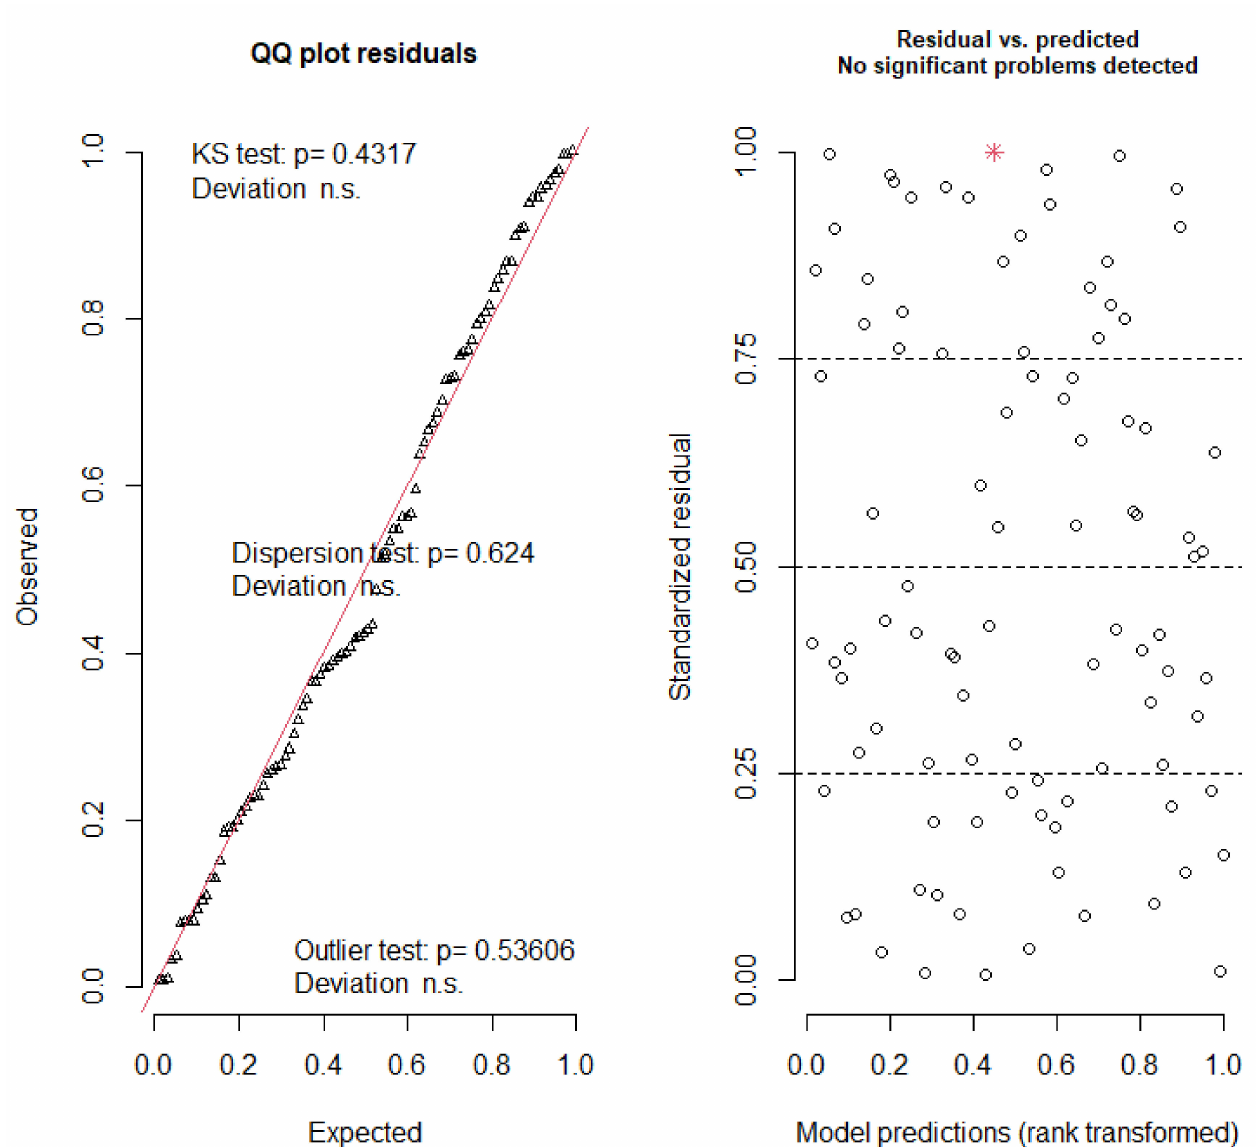
Figure A3. Q-Q plot and the residuals versus the predicted for the rate of catch model of Lucilia cuprina